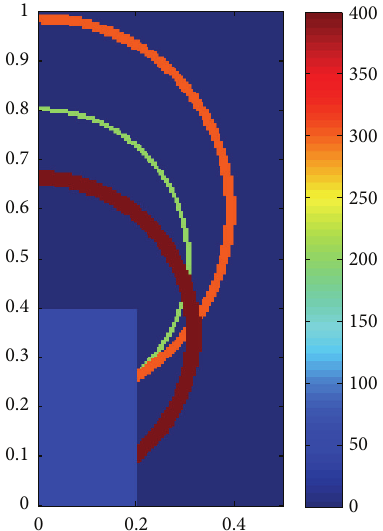
Figure 1: The phantom object for testing the reconstruction algo- rithm.